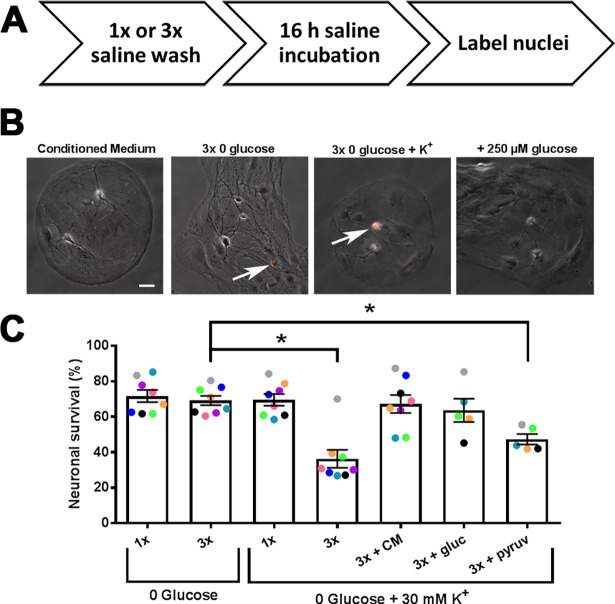
Neuronal viability is resilient to prolonged glucose deprivation.(A) Schematization of survival protocol. Culture medium was either exchanged for glucose-free saline prior to prolonged incubation (1x), or cultures were washed twice in glucose-free saline prior to prolonged incubation in the 3rd application of glucose-free saline for 16 h (3x). In some cases alterations were made to the incubation solution, such as the addition of 30 mM KCl, glucose, etc. Following prolonged incubation, propidium iodide was used to identify nuclei of compromised neurons. (B) Sample phase-contrast images of microcultures overlaid with red fluorescent propidium iodide stain (arrows) following prolonged incubation in conditioned medium, 3x glucose deprivation, 3x glucose deprivation + K+, and 3x glucose deprivation + K+, 250 μM glucose. Scale bar = 20 μm. (C) Summary of neuronal survival expressed as the percentage of propidium iodide-negative neurons in 10 semi-randomly chosen fields (see Materials and Methods). Symbols are color coded to indicate sibling cultures; different colors represent independent platings. (p<0.05, One-way ANOVA with Dunnett’s multiple comparisons test with 3x glucose deprivation as control). Data are represented as mean ± SEM. *p<0.05.